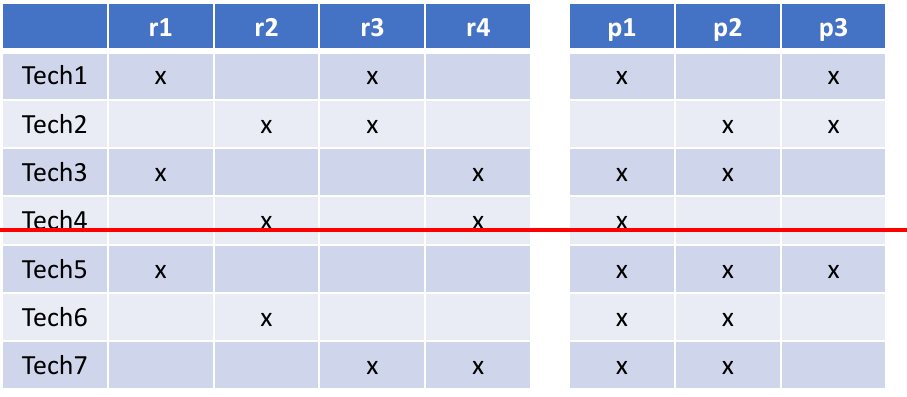
Figure 2. Left: Matrix representation of the SRNG events or risks for each technology implemented at the networking nodes. Right: Communication protocol matrix for different networking node